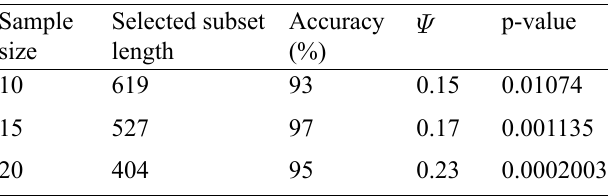
Fig. 2. Comparison of computational time (in second) for five methods under various sample sizes. Table 2. Accuracy and Y B for the presented method for sample size of 10, 15, and